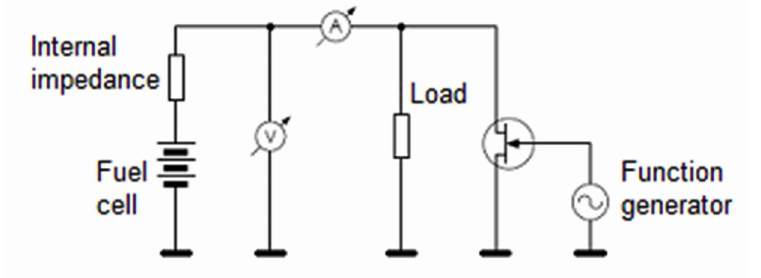
Figure 3. Principle of the load modulation method